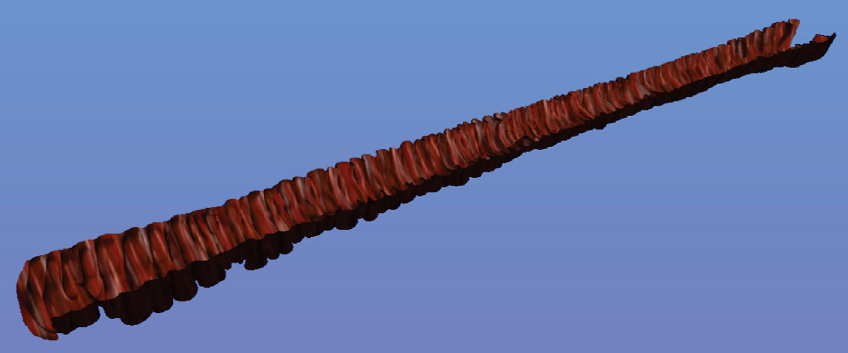
Fig. 15 Visualization results. (a) Original colon mesh. (b) Colon straightened by our method. (c) Slit-open colon. (d) Conformal flattening colored with Fiedler information [53].